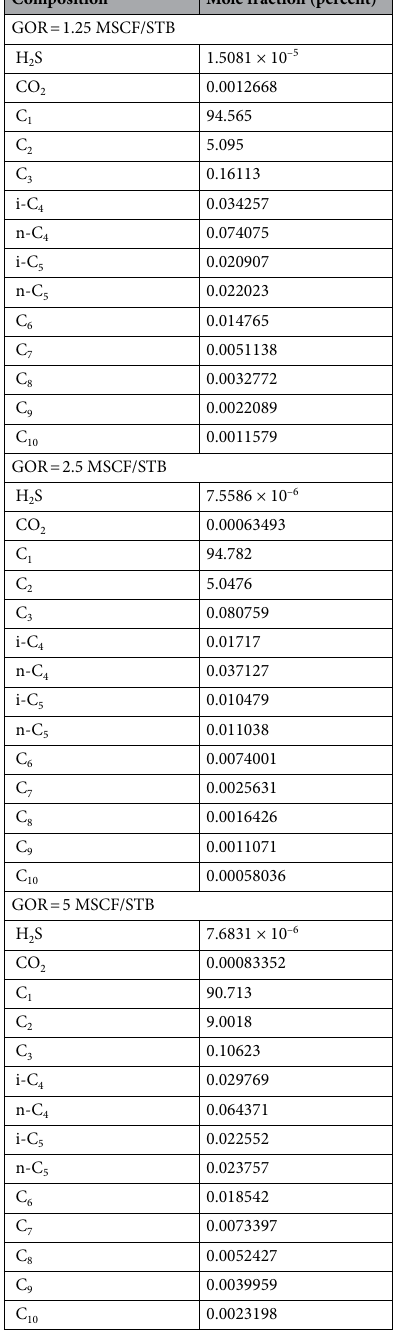
Table 2. The composition of rich gas with